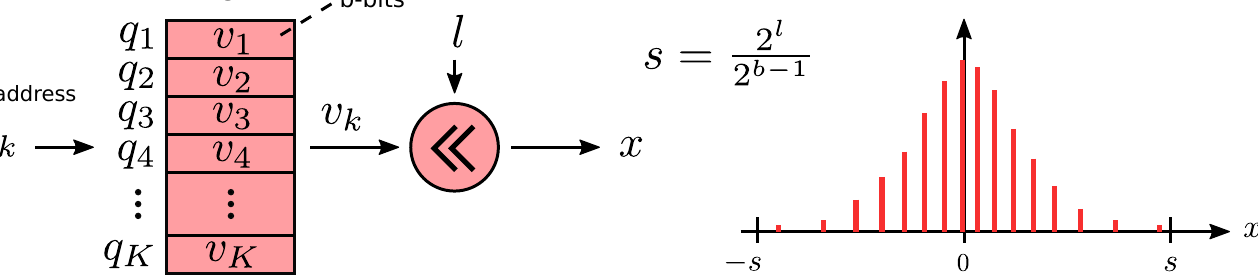
Figure 6. Our quantization scheme, which calculates a value x by translating a lookup-address q k into a b bit value v k and bit-shifts the results by l